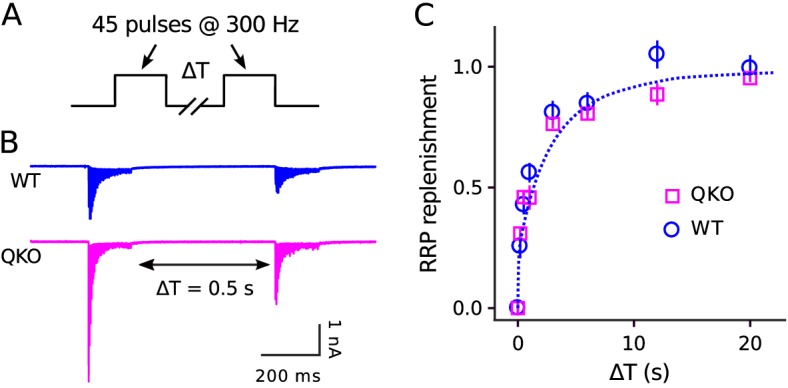
No alteration in timing of RRP replenishment at QKO calyces of Held.(A) Experimental design. (B) Averaged recordings for trials with a rest interval of 0.5s between trains from single preparations. (C) RRP replenishment vs time estimated as in Mahfooz et al. (2016); n ≥ 20 trials from 7 calyces for QKO and 8 trials from 3 calyces for WT. The dashed line is RRPt=1−e−∫α^t with α^t the decaying exponential defined by Eqn (4) in Mahfooz et al. (2016), except α^0=5.4/s to match the value used to generate curve ‘M’ in Figure 3D.